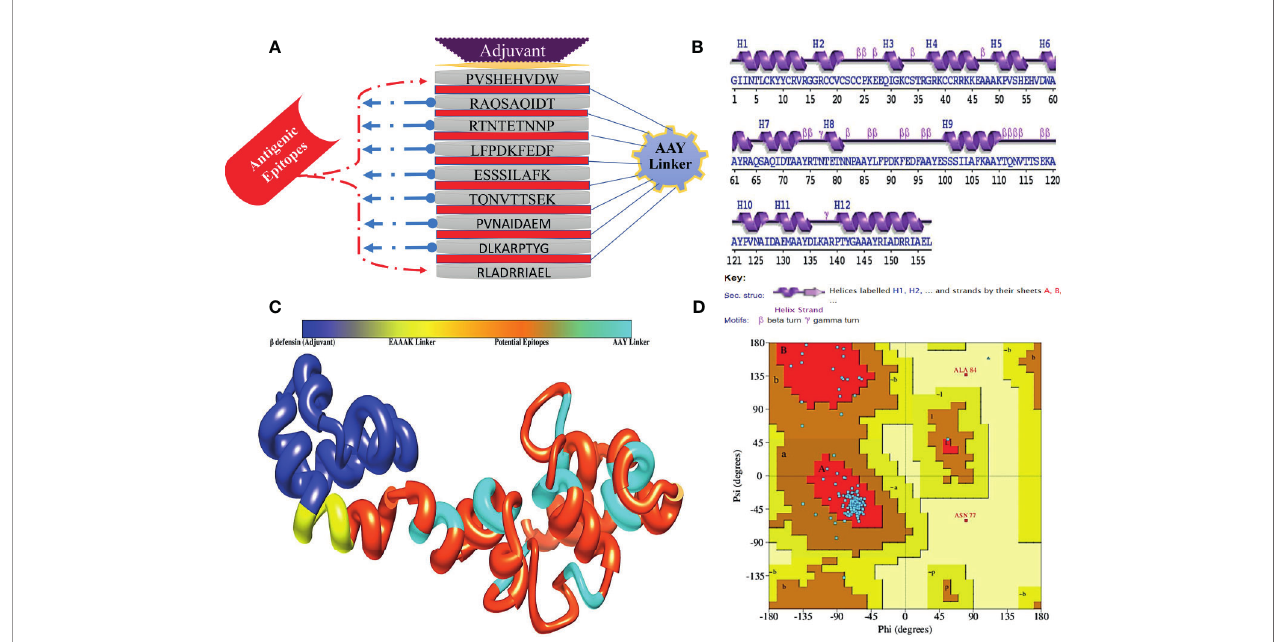
FIGURE 3 | (A) Schematic representation of MEV construct for CCHFV, (B) Secondary structure of MEV construct, (C) Predicted 3D structure of designed MEV construct and (D) Ramachandran plot of MEV